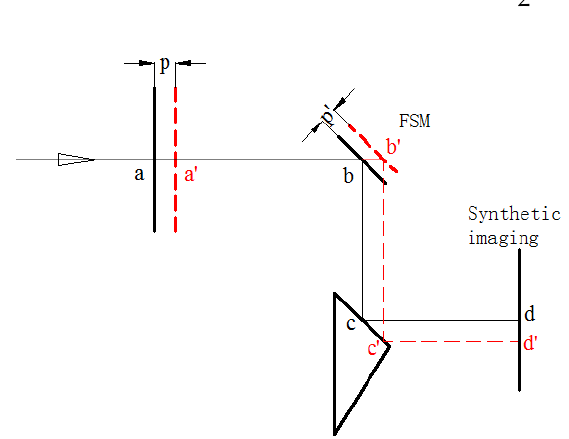
Figure 12. Comparison of optical paths when 0 piston error and p piston error.